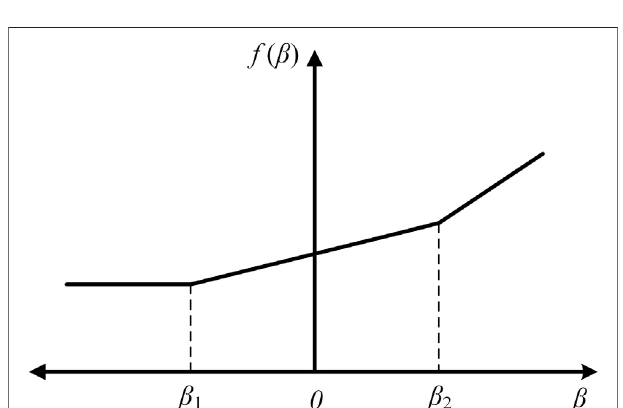
FIGURE 3 | β (cid:1) 0 is in the interior of the linearity interval.